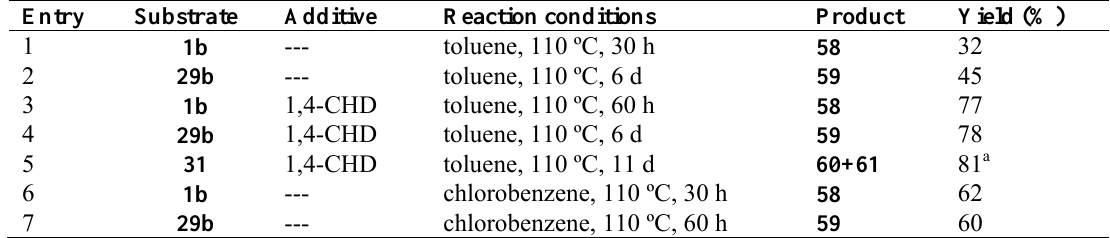
Table 5. Thermal cycloisomerizations of macrocycles 1b , 29b , and 31